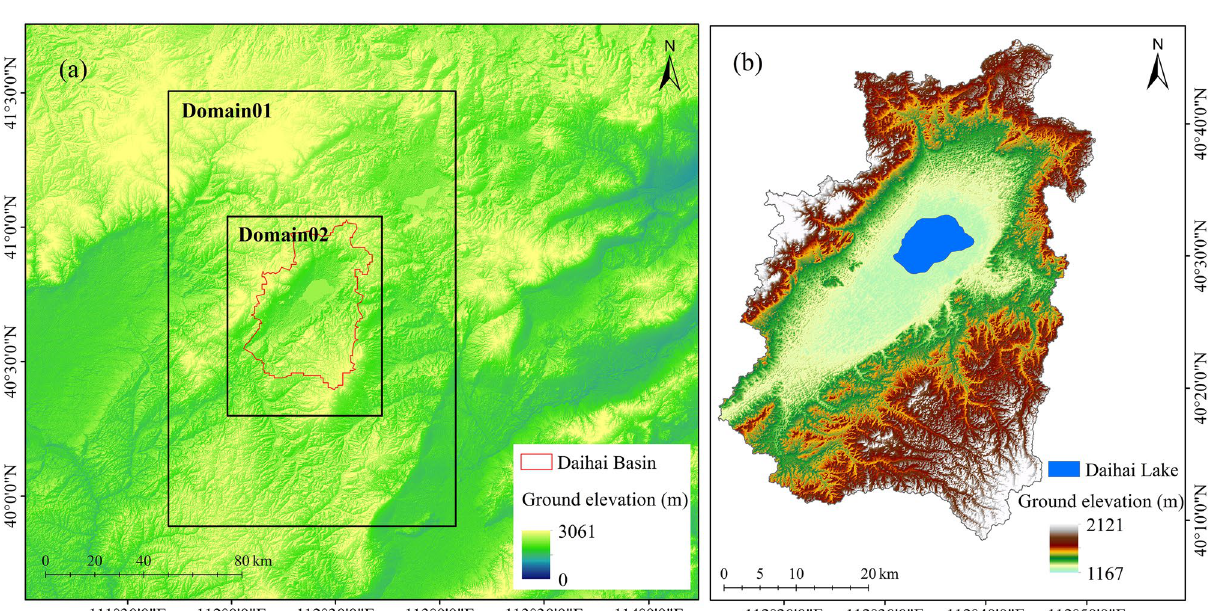
Figure 2. ( a ) Coverage and geographic location of spatially nested domains ( b ) Topographic of the Daihai